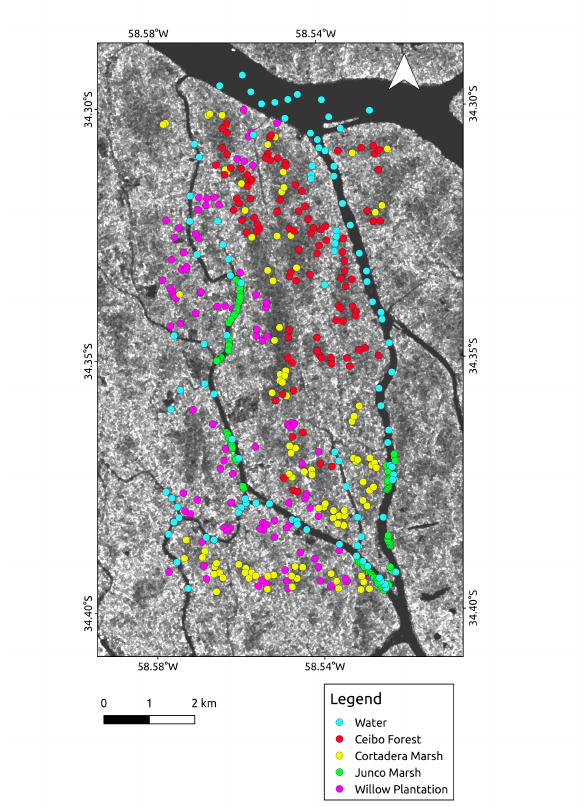
Figure 1. Location of the study area and the reference data for each land-cover class. The background image shows VH band from a Sentinel-1 scene of 1 September